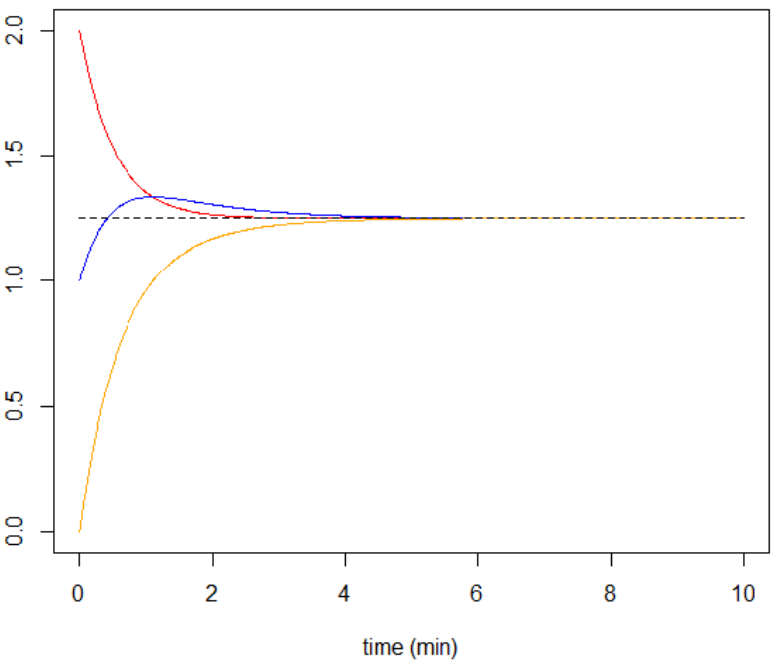
Figure 4. Illustration of the diffusion information for 3 nodes. Node 2 is connected to nodes 1 and 3, but nodes 1 and 3 are not connected. The initial conditions are Γ = 0, f ( 0,1 ) = 1, f ( 0,2 ) = 2 and f ( 0,3 ) = 0. We set D = 1. Blue is for f ( t ,1 ) , red is for f ( t ,2 ) , and yellow is for f ( t ,3 ) . The equilibrium state corresponds to the following